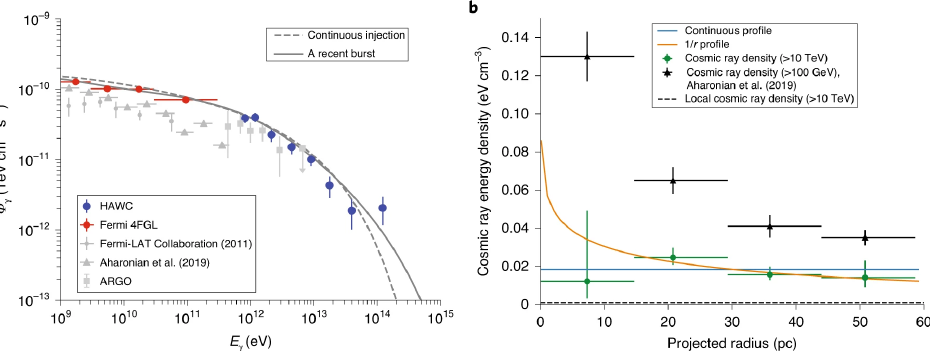
Figure 10. ( a ) Figures from [64]. Spectral energy distribution of the gamma-ray emission at the Cocoon region. HAWC errors on the flux points are the 1 sigma statistical errors. At low TeV energy, HAWC data agree with the measurements by the ARGO observatory [88]. The red and grey circles are the Fermi-LAT flux points published in [87,89], respectively. The grey triangles are from the Fermi-LAT analysis in [44]. The grey solid and dashed lines are the spectra derived from the hadronic modeling of the region. ( b ) Cosmic ray energy density profile calculated for four rings (0–15 pc, 15–29 pc, 29–44 pc, and 44–55 pc) centered at the OB2 association. The green circles are the cosmic ray densities derived above 10 TeV using HAWC gamma-ray data. The y errors are the statistical errors and the x error bars are the width of the x bins. The orange and blue lines are the 1/r profile for the case where the particles are continuously injected) and constant profile (signature of the burst injection), respectively. The black dashed line is the local cosmic ray density above 10 TeV, based on the Alpha Magnetic Spectrometer measurements. The black triangles are the cosmic ray densities above 100 GeV from